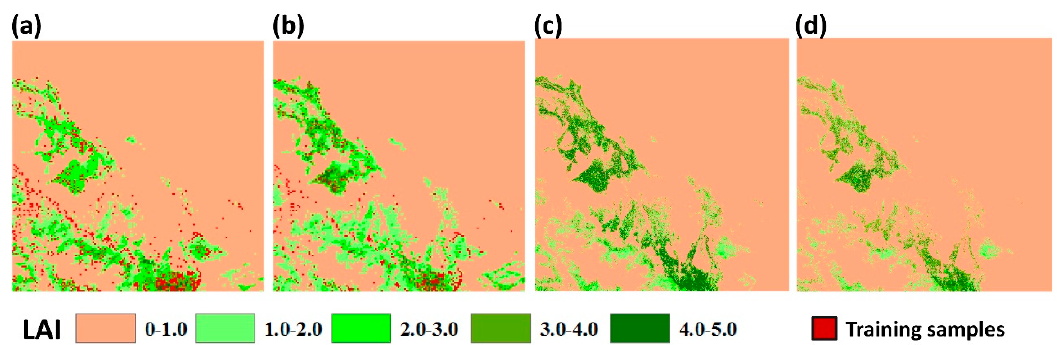
Figure 5. Multi-scale maps of LAI in July 2012: ( a ) GLASS LAI (1 km); ( b ) MODIS LAI (1 km); ( c ) D_LAI_GLASS (30 m); ( d ) D_LAI_MODIS (30 m). The red pixels are the training samples. Compared